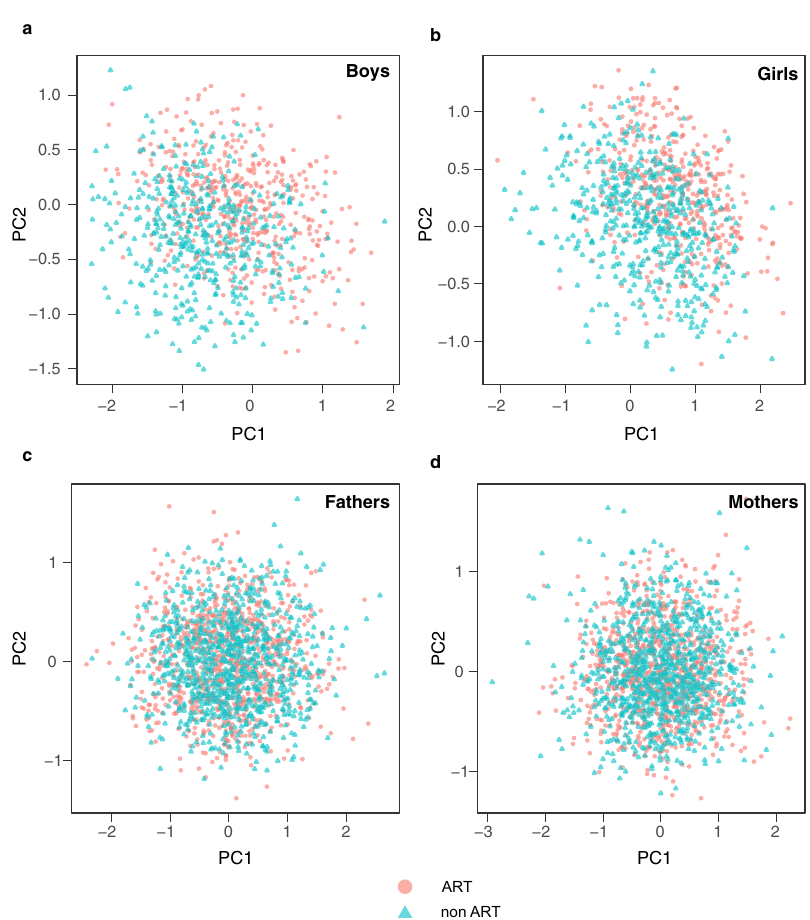
Fig. 4 Principal component analysis of DNA methylation data in ART conceived and naturally conceived newborns, and their parents. Scatter plots display the fi rst two principal components (PC1 and PC2) of ART conceived (pink circles) versus naturally conceived (blue triangles) boys and girls, and their parents. a 505 ART conceived boys and 470 naturally conceived boys were examined. b 457 ART conceived girls and 513 naturally conceived girls were examined. c 969 fathers for ART conceived children, 980 fathers for naturally conceived children were examined. d 970 mothers for ART conceived children, 986 mothers for naturally conceived children were examined. Source data are provided as a Source Data fi